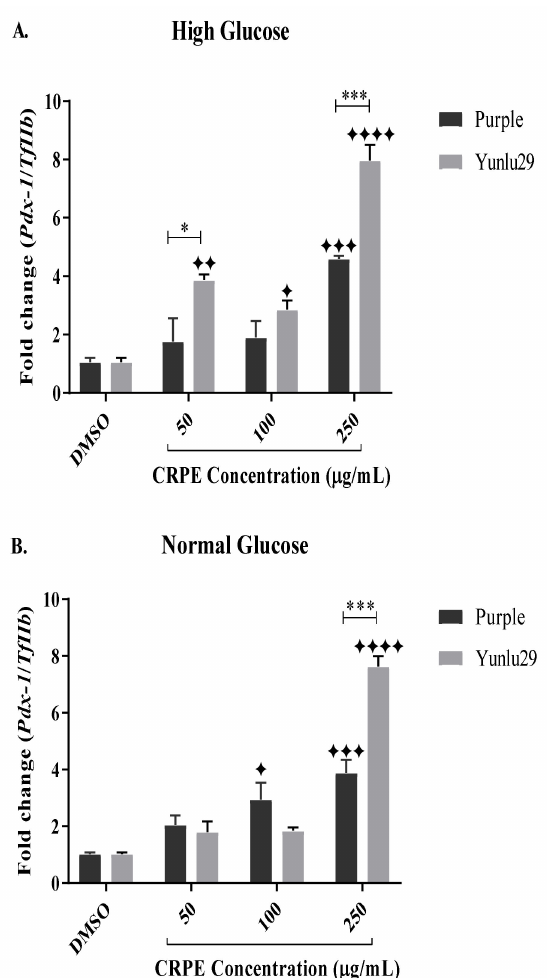
Figure 5. Expression of Pdx-1 in INS-1E cells. A ) high glucose (25 mM). B ) normal glucose (11.1 mM). n = 3. Stars indicate significant di ff erences between extracts and DMSO, where (cid:70) p < 0.05, (cid:70) (cid:70) p < 0.01, (cid:70)(cid:70)(cid:70) p < 0.001, (cid:70)(cid:70)(cid:70)(cid:70) p < 0.0001. Asterisks indicate significant di ff erences between the extracts, where * p < 0.05, *** p < 0.001;two-way ANOVA with Turkey’s multiple comparison post hoc test. Data is presented as mean ± SEM. Pdx-1—pancreatic and duodenal homeobox-1; TfII β —transcription factor II β ; INS-1E—Insulinoma cells; DMSO—dimethyl sulfoxide; CRPE—coloured rice phenolic